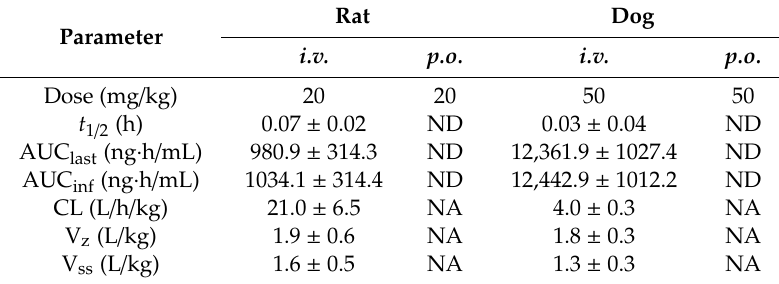
Figure 1. AUC last : area under the plasma concentration-time curve from time zero to last measurable concentration. AUC inf : area under the plasma concentration-time curve from time zero to infinity. Data are presented as mean ± S.D. ( n = 6). ND: not determined; NA: not applicable.